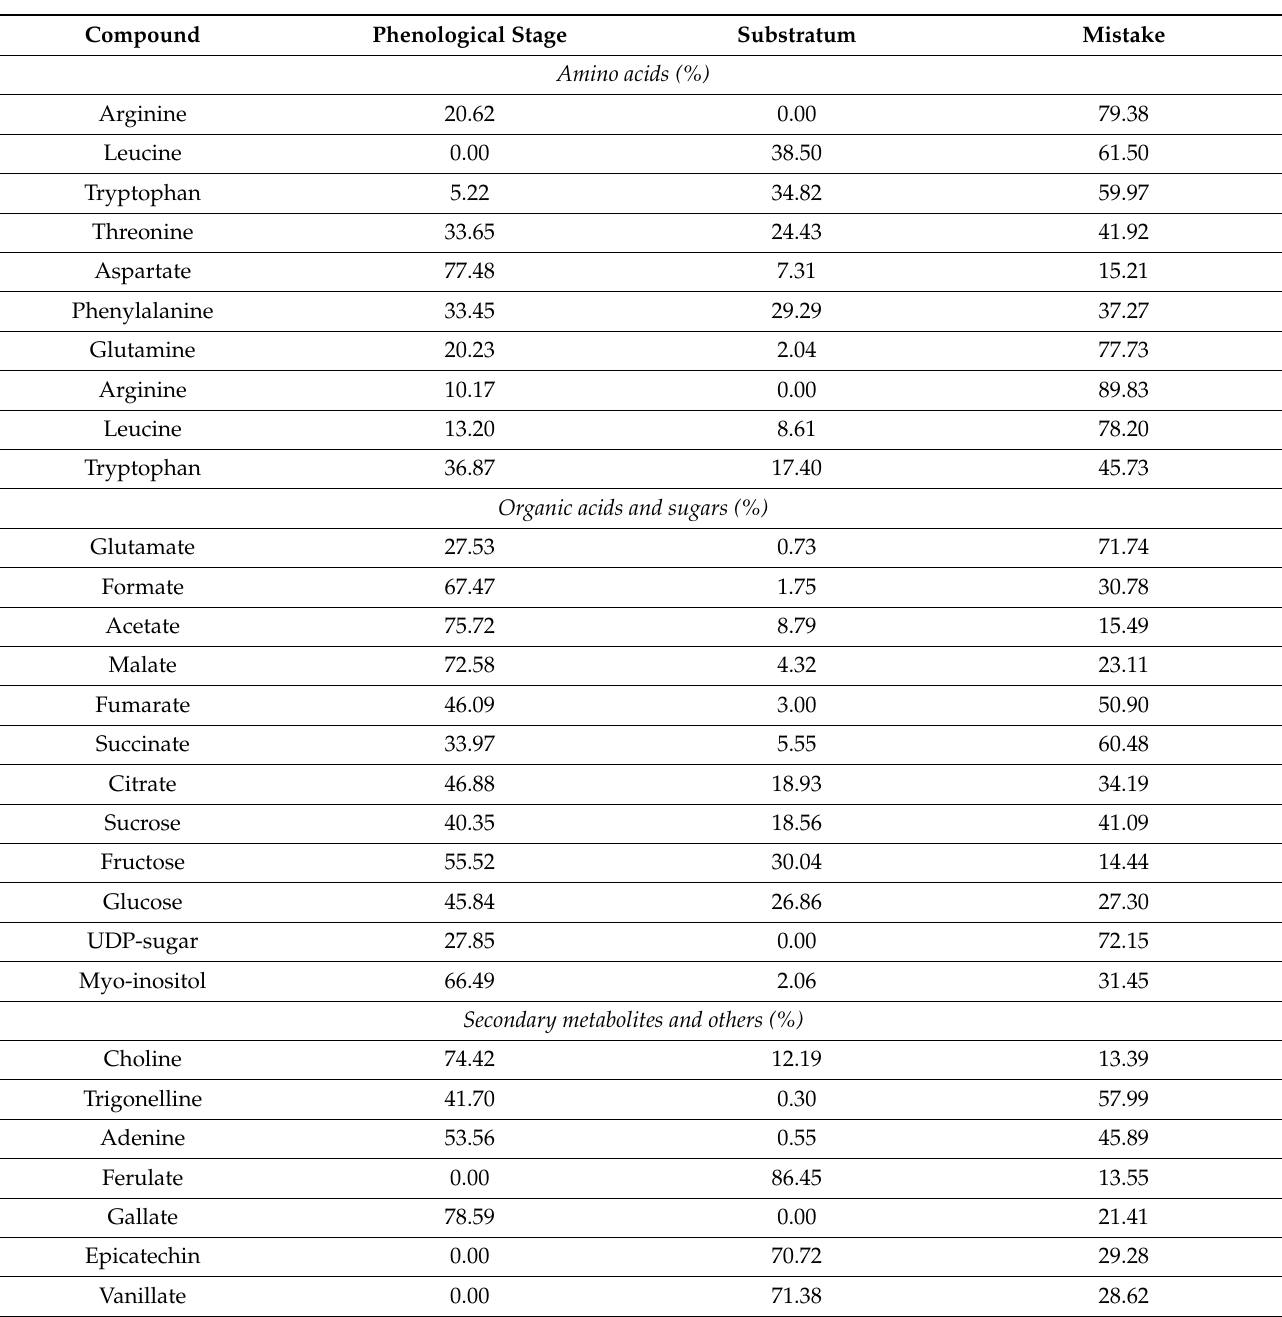
Table 5. Analysis of variance components (%) for the leaves metabolomic analysis. For each of the variables analyzed, the amount of variability of each of the factors (substrate and phenological phase) is